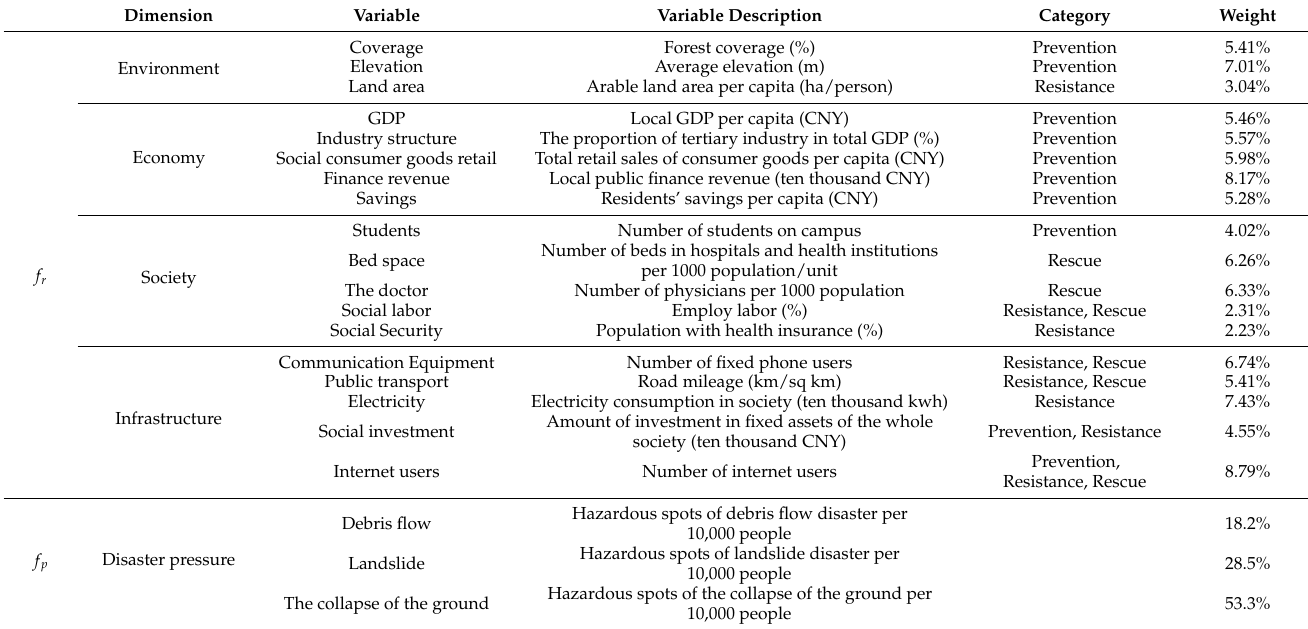
Table 1. Multi-hazard disaster resilience evaluation